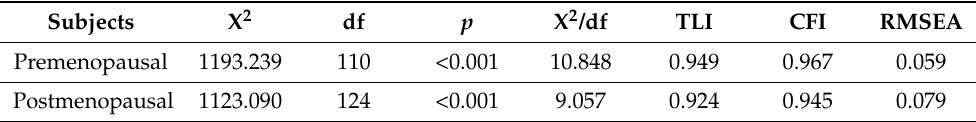
Table 3. Evaluation of the model fit in study subjects with bone mineral